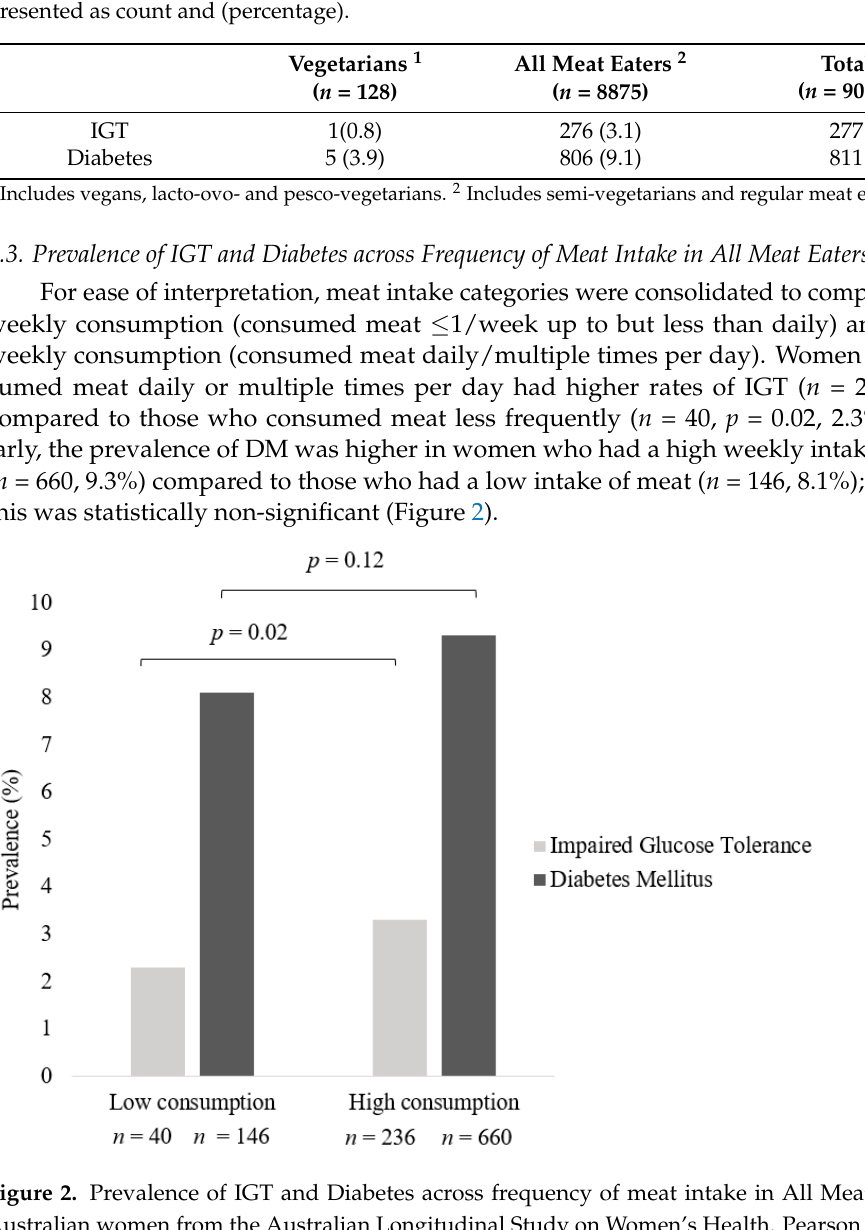
Figure 3. Prevalence of IGT and Diabetes across frequency of processed meat intake in All Meat Eaters in Australian women from the Australian Longitudinal Study on Women’s Health. Pearson chi-square test was used to compare prevalence of disease across groups. Data are presented as percentages. Low consumption encompasses individuals who consumed processed meat ≤ 1/week up to but less than daily and high consumption those who consumed processed meat daily/multiple times per day.